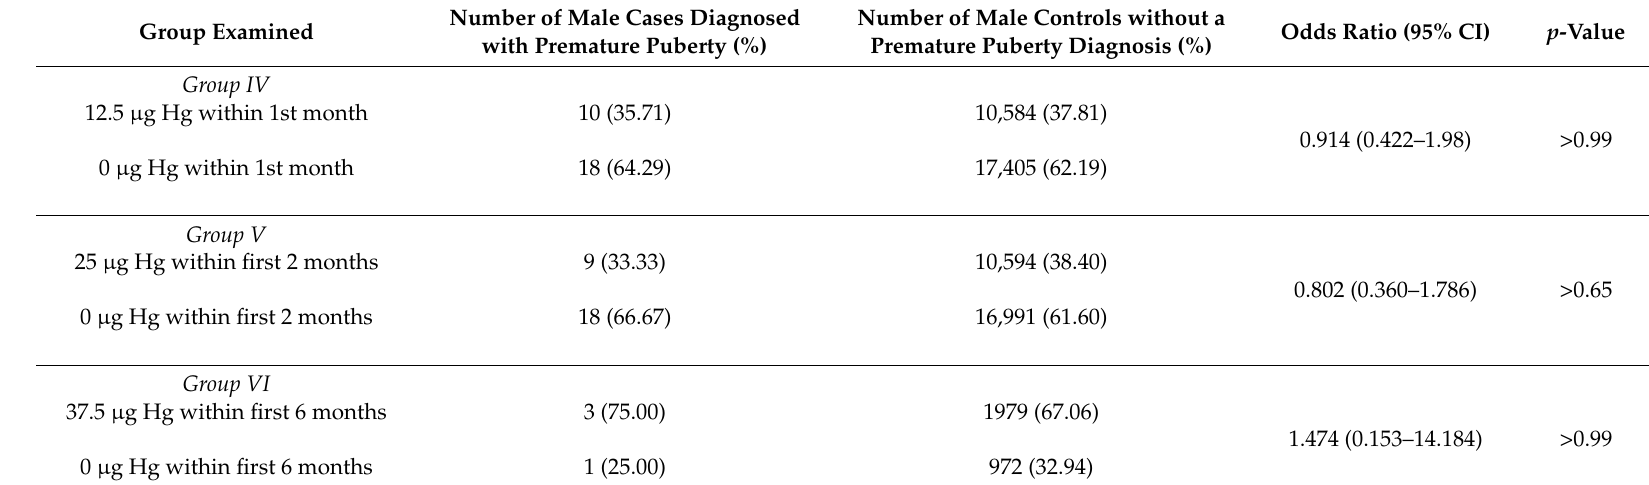
Table 2. This study summarizes the exposure to Hg from Thimerosal-preserved HepB immunizations administered among male cases with a premature puberty diagnosis compared to the male control subjects 1 , within the database of the